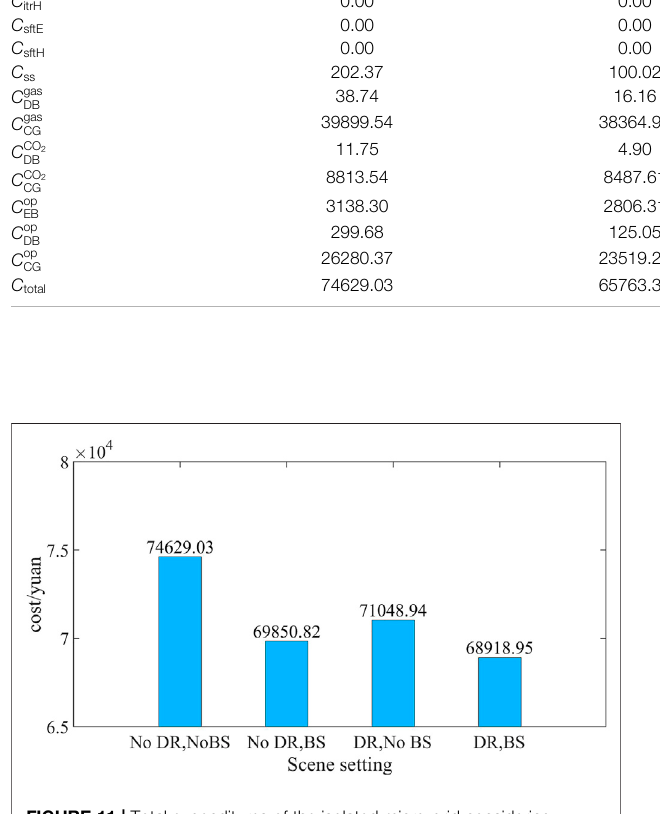
FIGURE 11 | Total expenditures of the isolated micro-grid considering the cost of electrical energy storage.